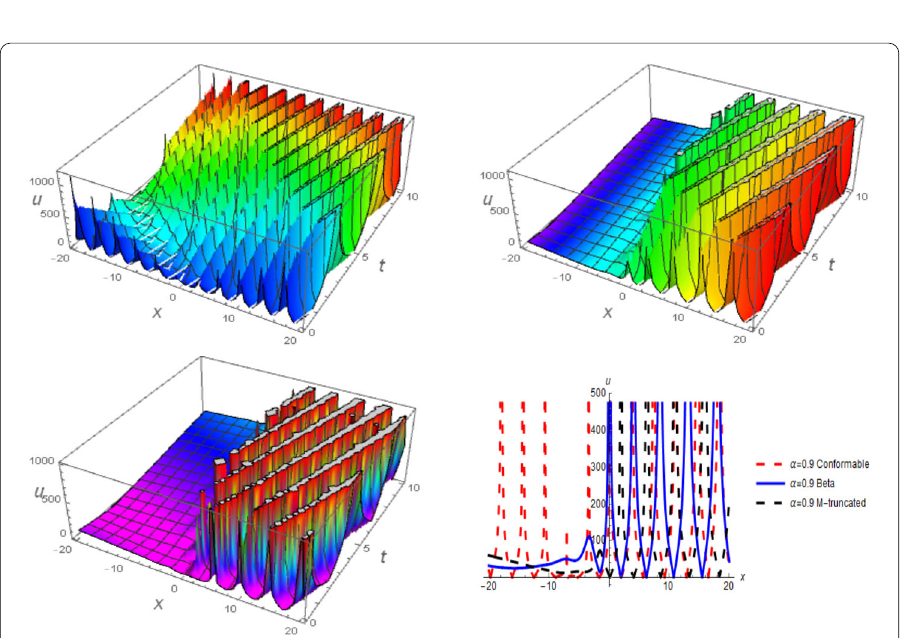
Figure 8 ( a ) 3D-plot of u 8 for conformable, ( b ) 3D-plot of u 8 for beta with α = 0.9. ( c ) 3D-plot of u 8 for M-truncated, ( d ) 2D-plot of u 8 with t = 1